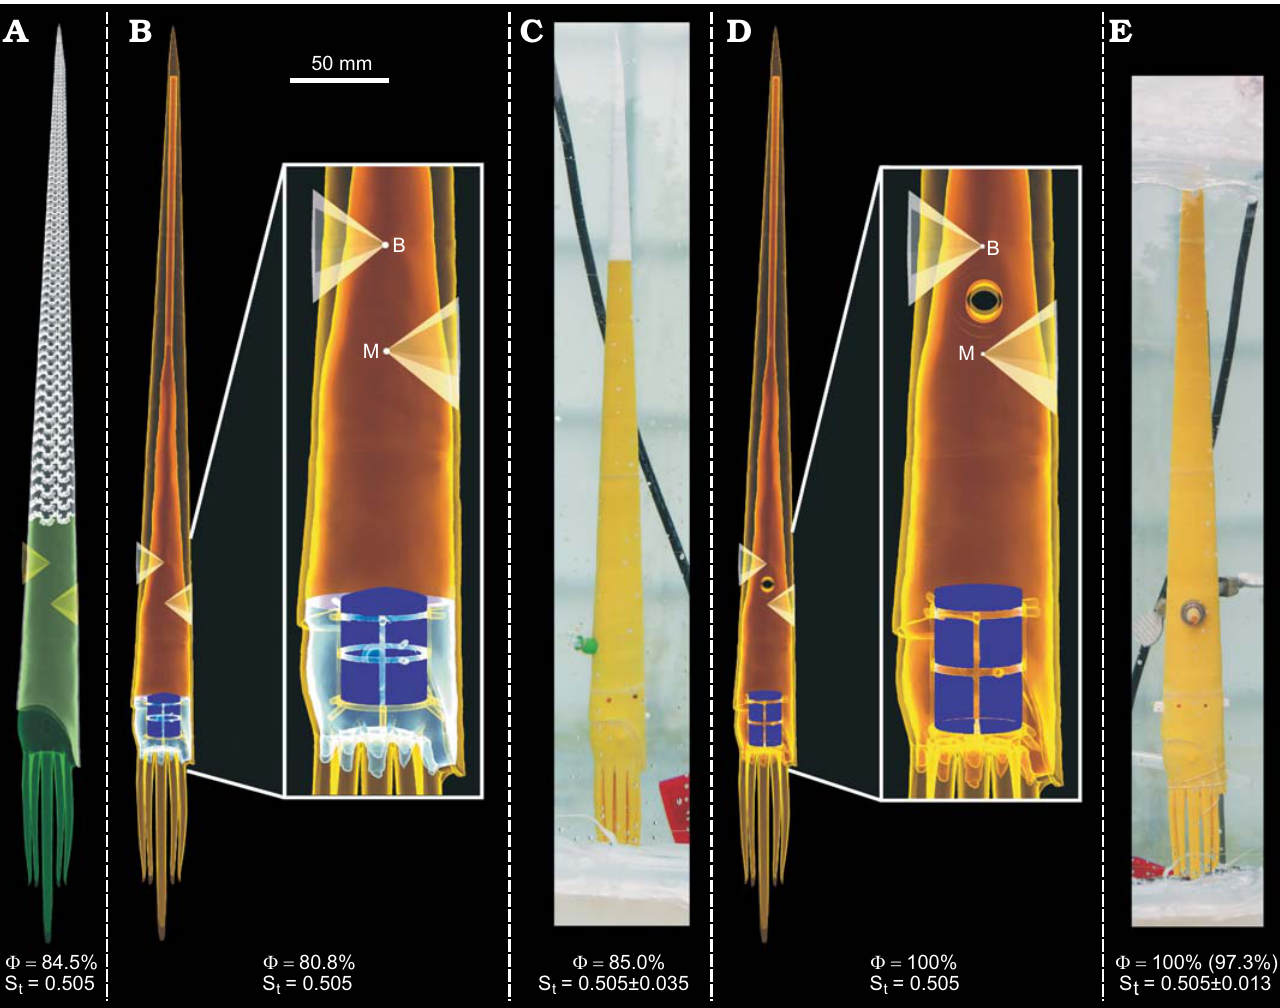
Fig. 9. Virtual and physical hydrostatic models of Baculites compressus with computed percentage of the phragmocone emptied for neutral buoyancy ( Φ ) and hydrostatic stability (S t ). Green, soft body; grey, shell; red, gas; blue, liquid; yellow, PLA plastic; purple, bismuth counterweight; B, center of buoy- ancy; M, center of mass. A . Virtual model with an even distribution of cameral liquid and gas in the phragmocone (center of mass of cameral liquid and gas = center of volume of the phragmocone; cameral liquid and gas not shown). B . Modified virtual model with simplified internal geometry (“Modified 1” in Table 3). C . Neutrally-buoyant, 3D printed model. D . Modified virtual model with simplified internal geometry and axel hole through pivot point of rotation (“Modified 2” in Table 3). E . Neutrally-buoyant, 3D printed model fixed to an axel and silicone tubing used to supply thrust in the ventral direction. For this model, the mass discrepancy (Table 5) resulted in a slightly lower of 97.3%, but was held constant at 100%. All computed errors in S t were computed assuming that the total mass discrepancy was distributed in the positive or negative